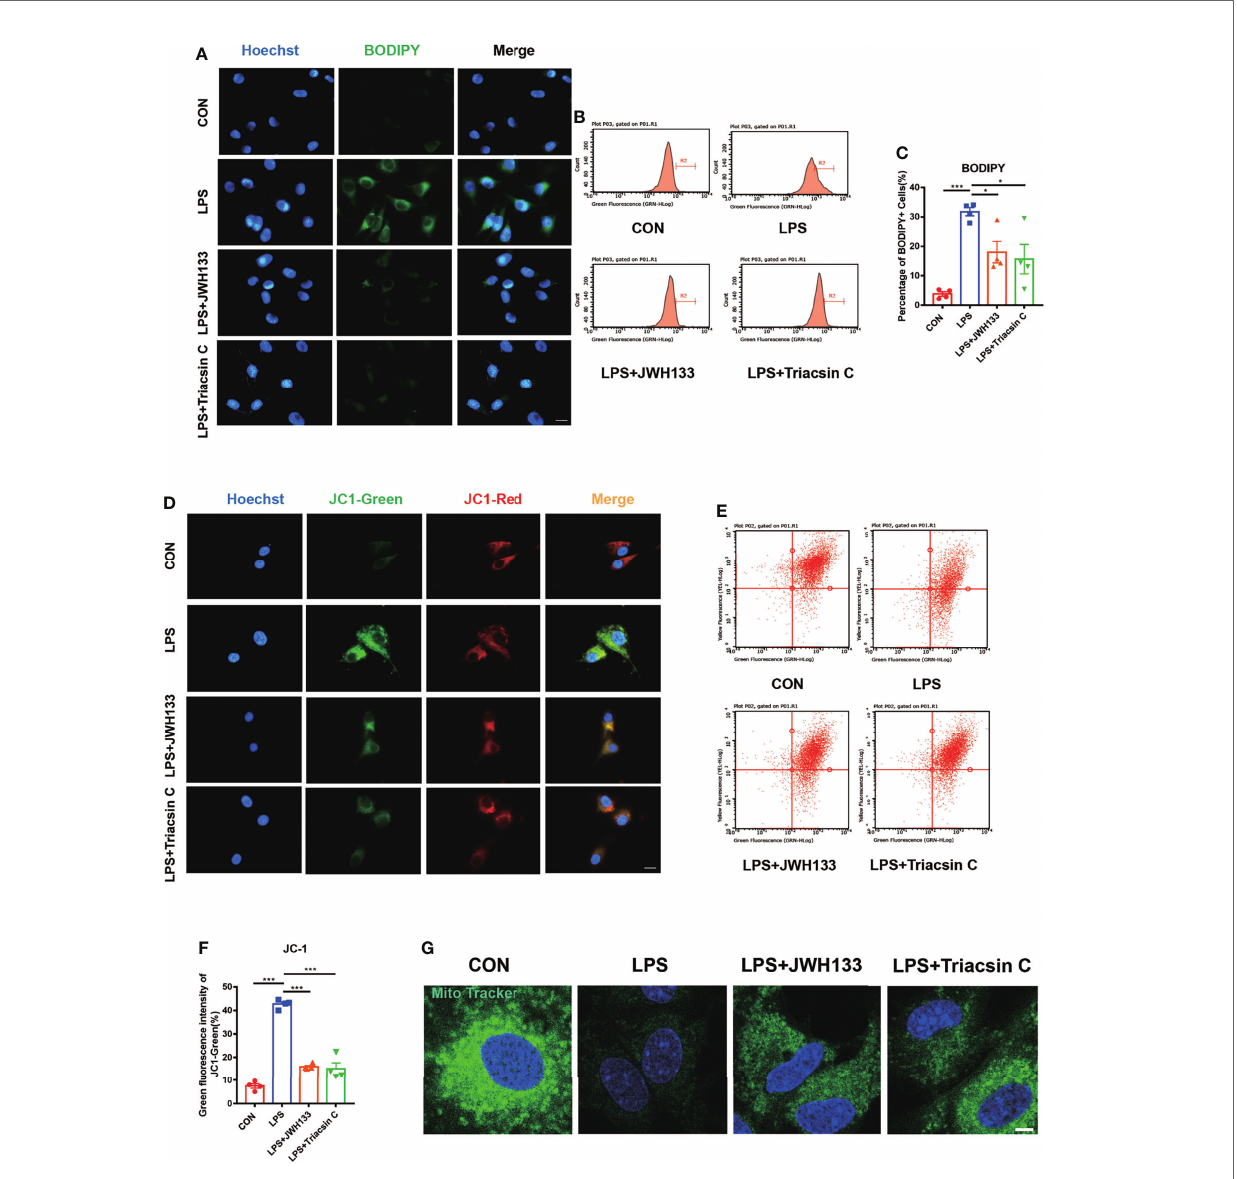
FIGURE 4 | (A) U87 cells incubated with 1 m M of JWH133 or 1 m M of Triacsin C for 1 h and stimulated with 100 ng/mL of LPS for 6 h, collected for fl uorescence photography (Scale bar= 20 m m) and cell fl ow analysis. (B) Statistical data in (C) (means±SEM, for 4 independent experiments). (D) JC1-green fl uorescence and JC1-red fl uorescence measured by fl ow cytometry in each group (scale bar=20 m m). (E) Flow cytometric analyses of the mitochondrial function by JC-1 assay and green fl uorescence intensity of JC1-green. (F) Flow cytometry of the green fl uorescence intensity of JC1-green (means±SEM, for 4 independent experiments). (G) After cell treatment, cells were incubated with Mitochondrial Tracker Green for 30 minutes at 37°C, and images were captured under confocal microscope (scale bar=50 m m). NS means not signi fi cant, * P < 0.05, ** P < 0.01, *** P < 0.001 compared with the corresponding group, as determined by